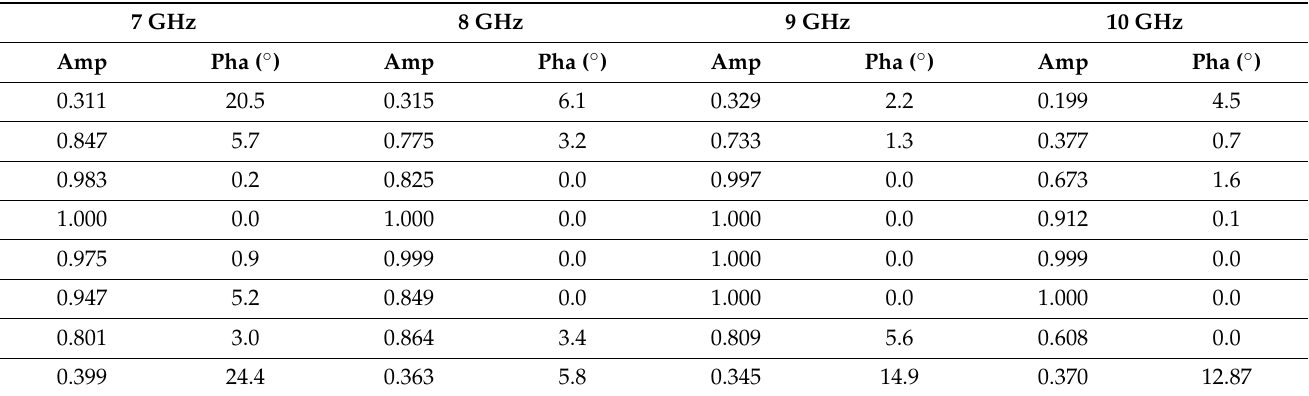
Table 9. Optimal weight vectors for wide-nulling optimization at four